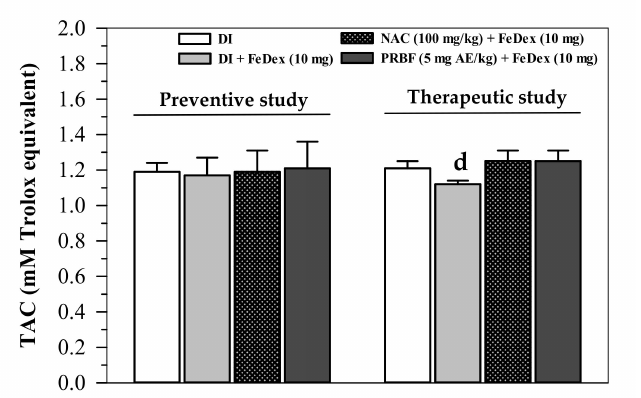
Figure 4. Levels of TAC in the plasma collected from FeDex-loaded mice that had been treated with DI, NAC and PRBF. In the preventive study, mice were treated with DI, NAC (100 mg/kg) and PRBF (5 mg AE/kg) for 14 d. This was followed by a single ip injection of 10 mg FeDex after the last